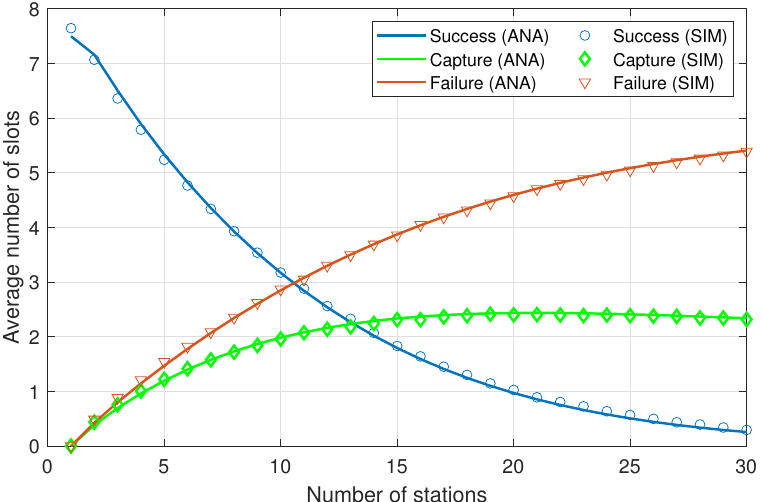
Figure 9. Average number of slots with successful single transmission, captured packet, and failure, within a RAW slot interval of length T S = 20ms and channel capture threshold z = 8dB.